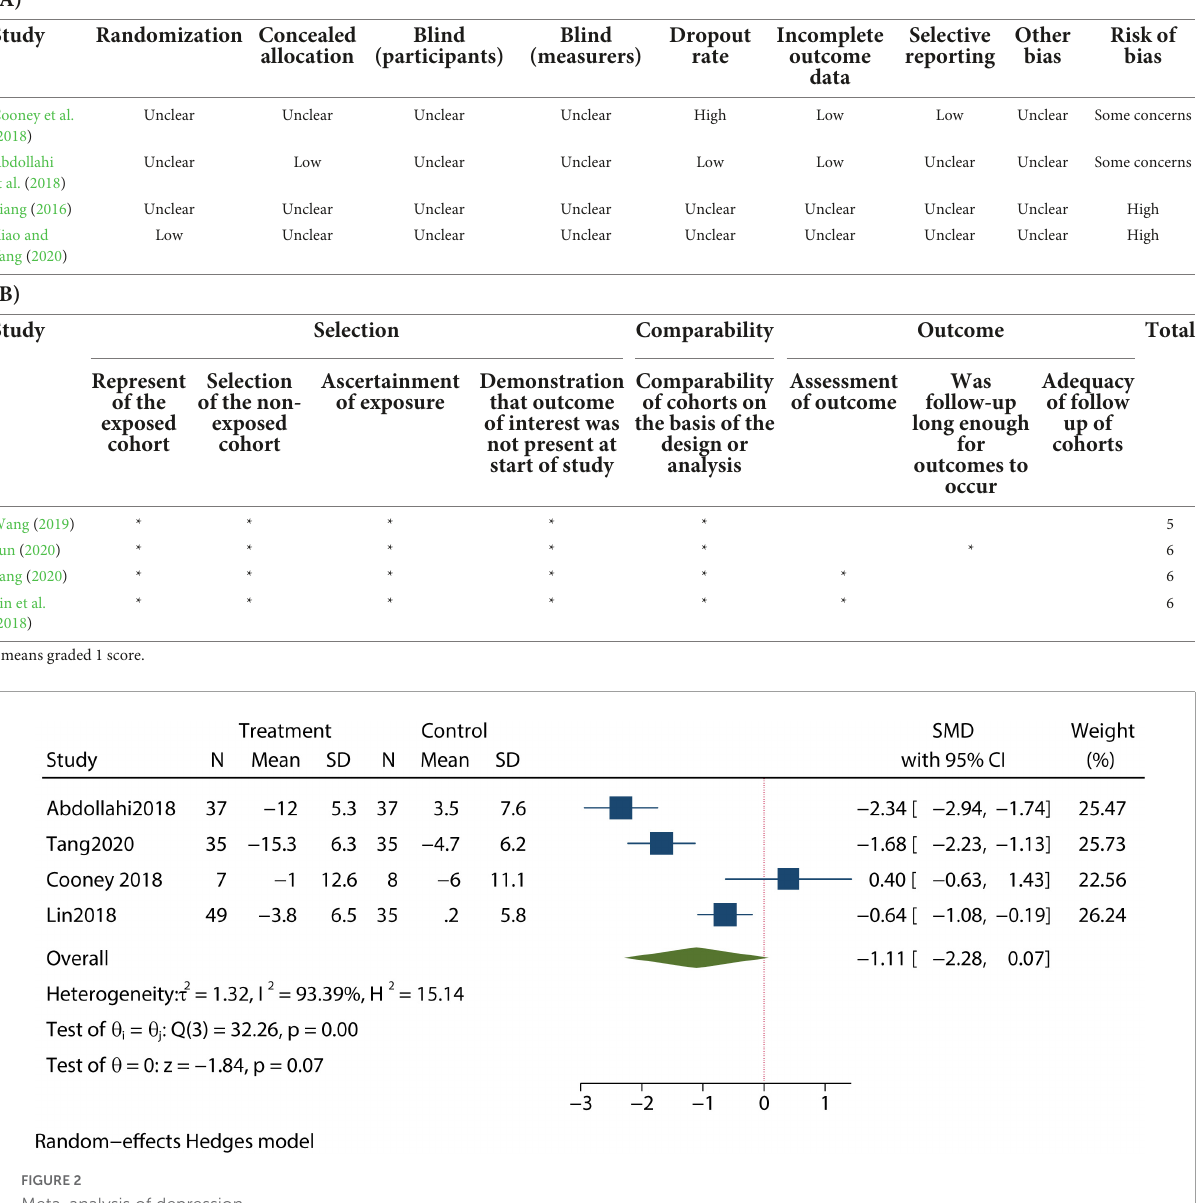
TABLE 2 Summary of risk of bias assessment.